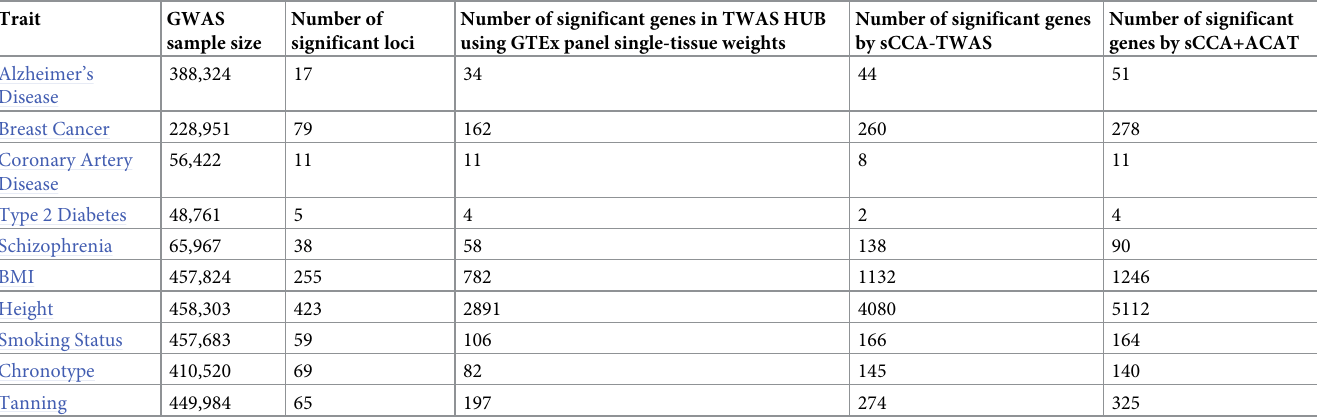
Table 1. Summary of data application